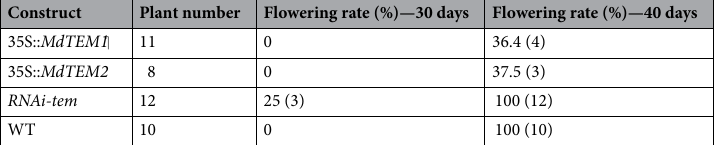
Table 1. Comparison of flowering rate in overexpressed and silenced lines after 30 and 40 days. Numbers in parentheses represent the number of flowering plants.